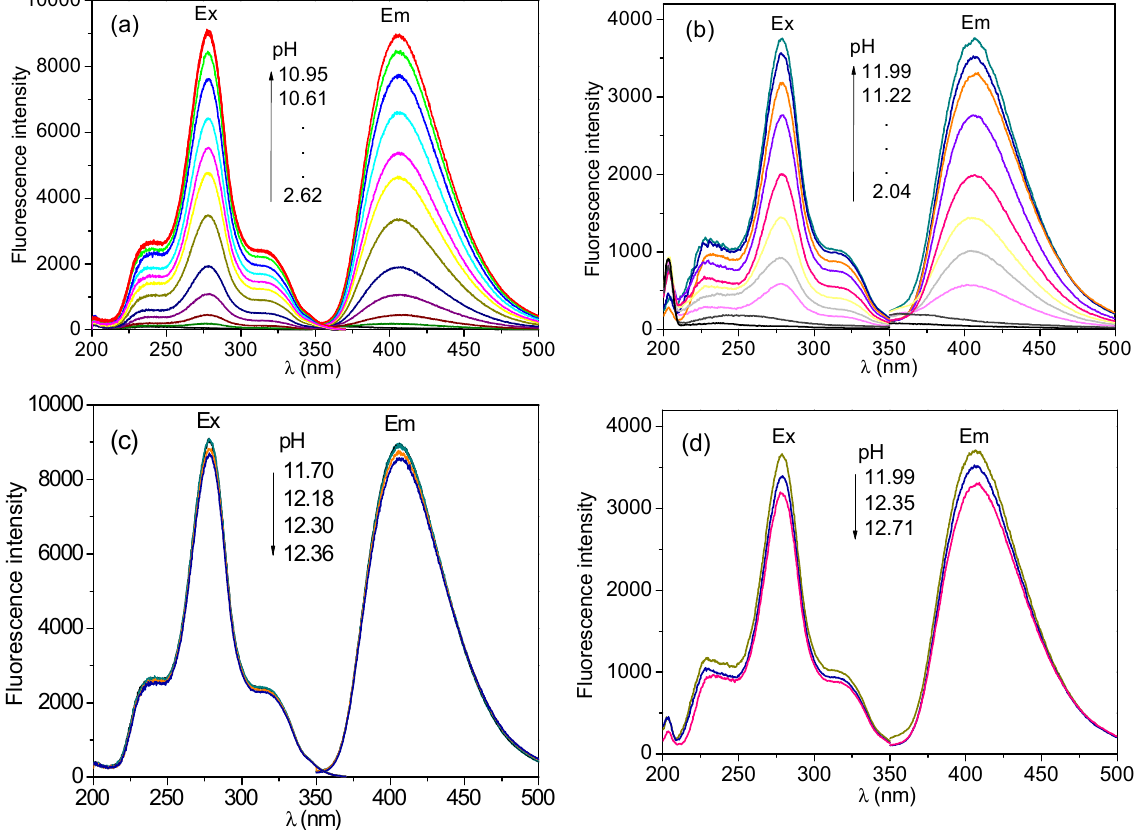
Figure 8. Fluorescence spectra of CH ( a , c ) and ECH ( b , d ) aqueous solutions with various pH. c CH = 0.407 μ g·mL − 1 , c ECH = 0.204 μ g·mL − 1 , MeOH 10%, λ ex / λ em : 279 nm/410 nm.